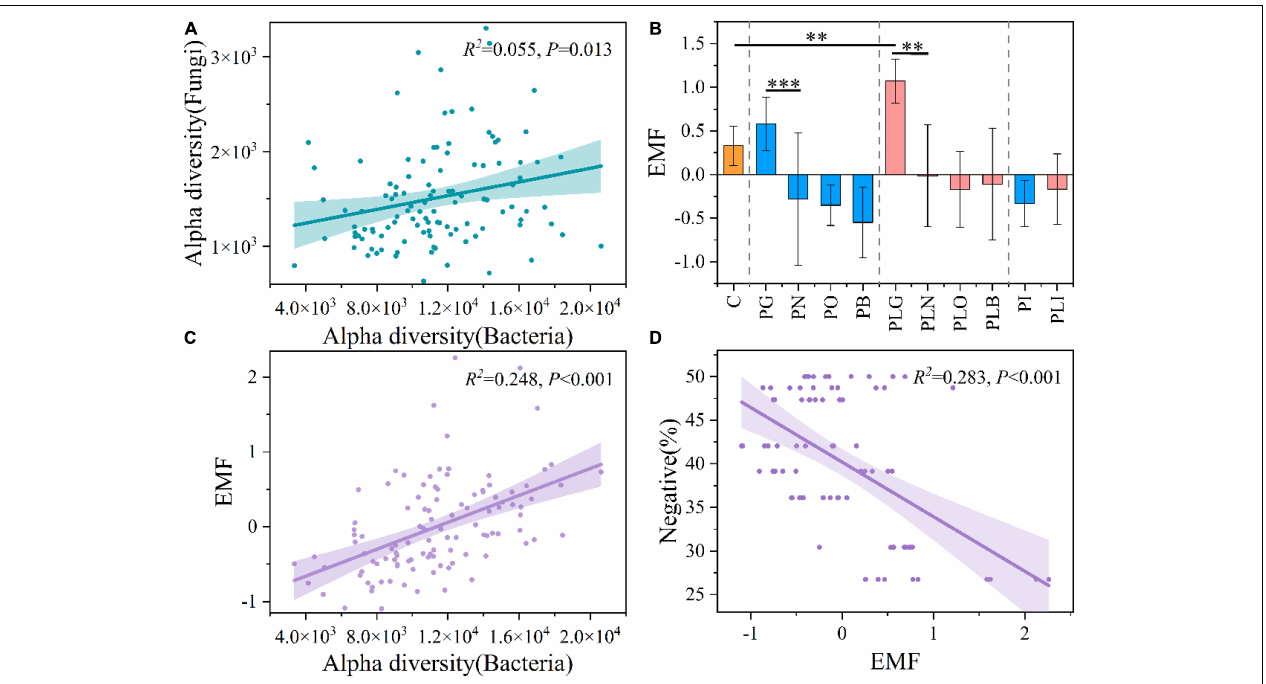
FIGURE 2 | The linear regression between bacterial and fungal α diversity (A) . The ecosystem multifunctionality (EMF) in each group (B) . The linear regression between EMF and bacterial α diversity (C) , and between EMF and negative proportion of networks in Figure 7 (D) . The area above and below the fitting line represents the 95% confidence interval. C, natural grass; P, pika disturbance; PL, grazing and pika disturbance; G, grassland; N, new mound; O, old mound; B, bare land; I, inside the mound. Significant indicator by ∗∗ P < 0.01 and ∗∗∗ P < 0.001.